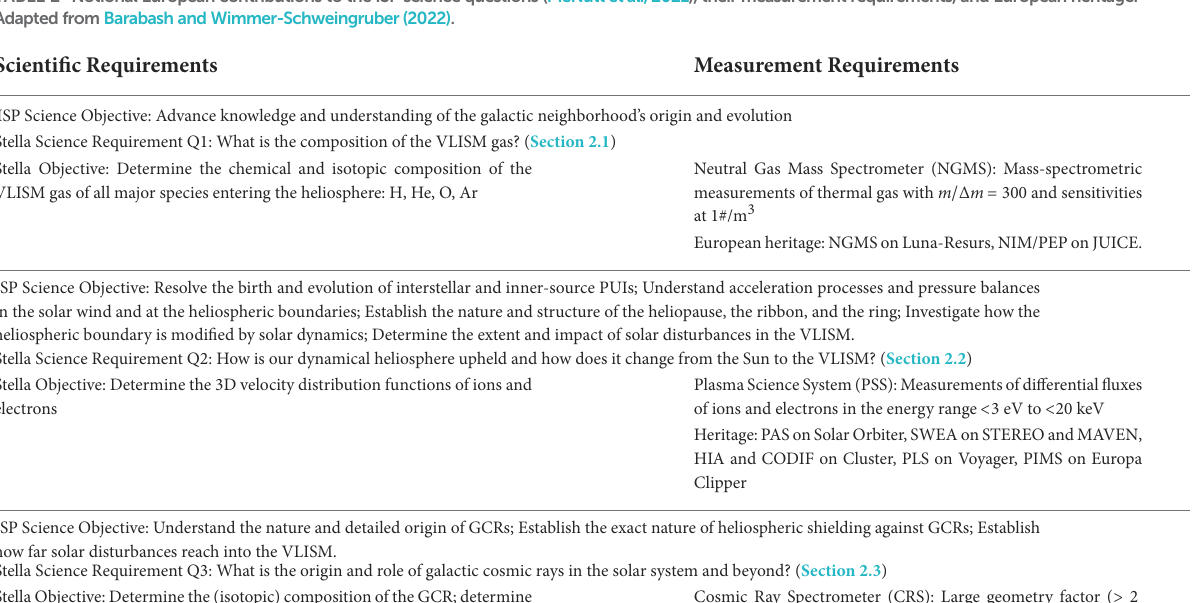
TABLE 2 NotionalEuropeancontributionstotheISPsciencequestions(McNutt et al., 2021),theirmeasurementrequirements,andEuropeanheritage. AdaptedfromBarabashandWimmer-Schweingruber